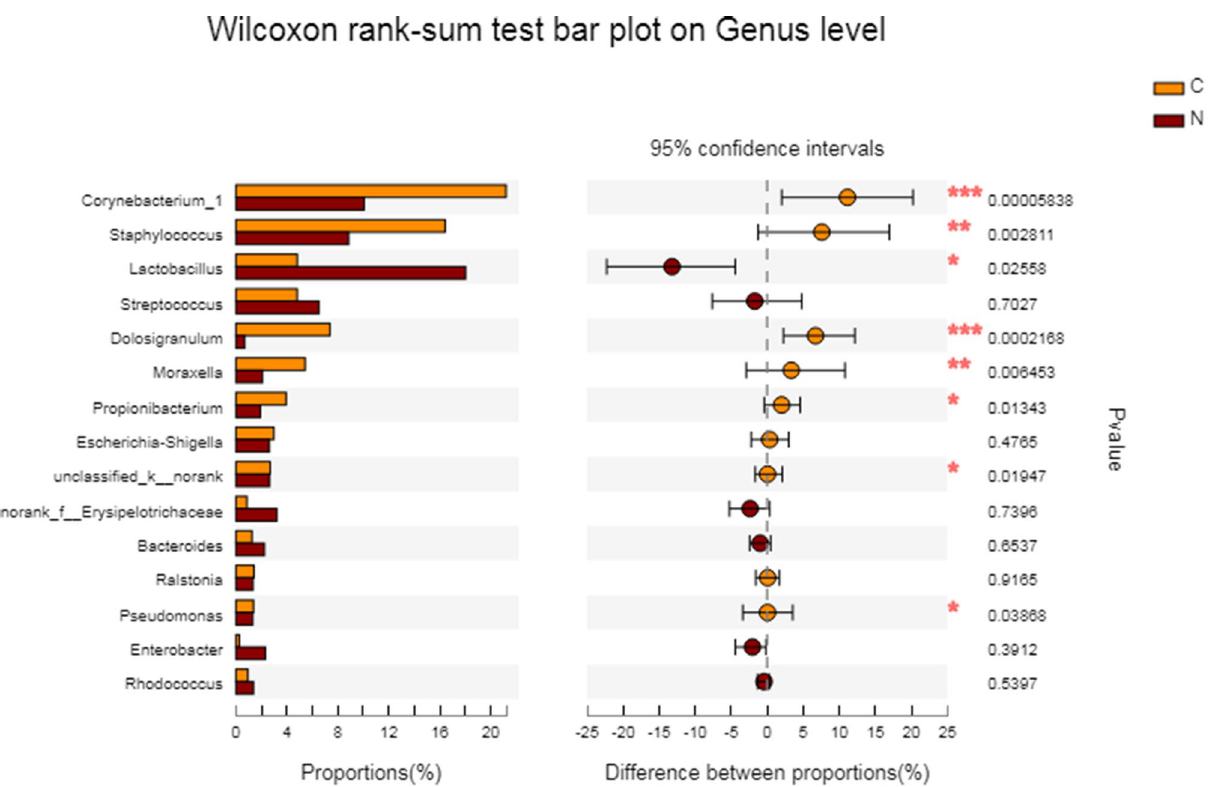
Figure 2. The Wilcoxon rank sum test was used to compare the difference in nasal microbial colony composition between recurrent and non-recurrent nasal polyp patients at the general level. Note : The right side of the figure shows the P value before FDR correction, *0.01 < P ≤ 0.05, **0.001 < P ≤ 0.01, *** P ≤ 0.001. After correction by FDR, only Corynebacterium had a PDR P = 0.047, and Dolosigranulum had PDR P = 0.012; the difference was statistically significant.